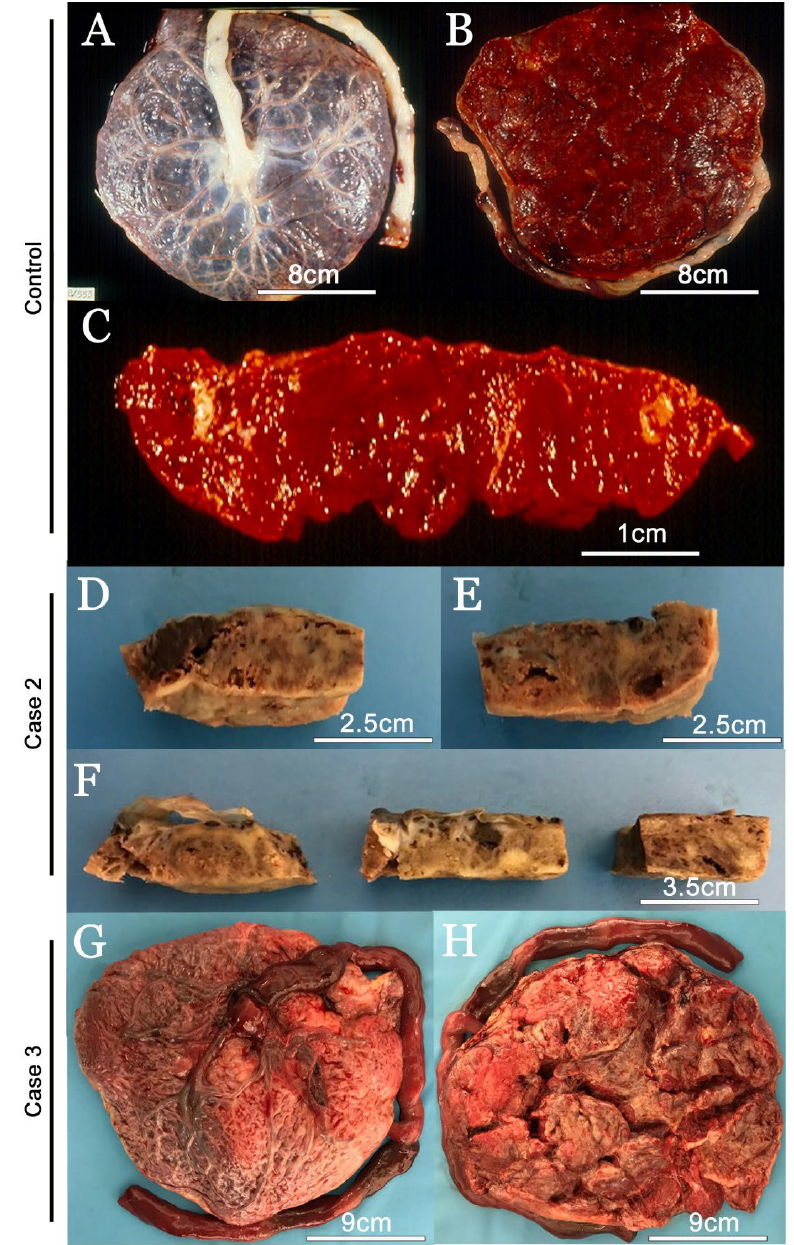
Figure 1. Macroscopic evaluation of placentas. ( A – C ) Prepandemic COVID-19 control fresh pla- centa; ( A ) fetal face; ( B ) maternal face; ( C ) cleaved placenta; ( D – H ) SARS-CoV-2-infected placentas; ( D – F ) cleaved and fixed placenta of the second case; ( G ) fresh fetal face of the third case; ( H ) fresh